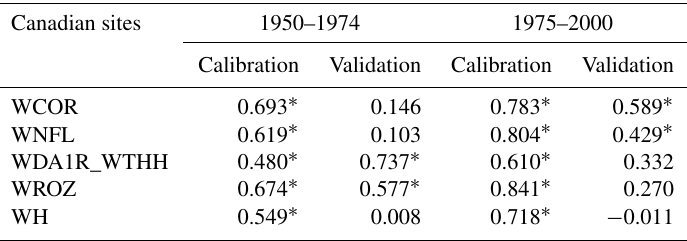
Table 5. Pearson correlation coefficients between tree-growth observations and simulations at the aggregated Eastern Canadian sites (Fig. 1b) with MAIDEN using NRCAN (5arcmin) as climatic inputs (Table 2) for the respectively 1950–1974 and 1975–2000 calibration and valida- tion periods and vice versa.